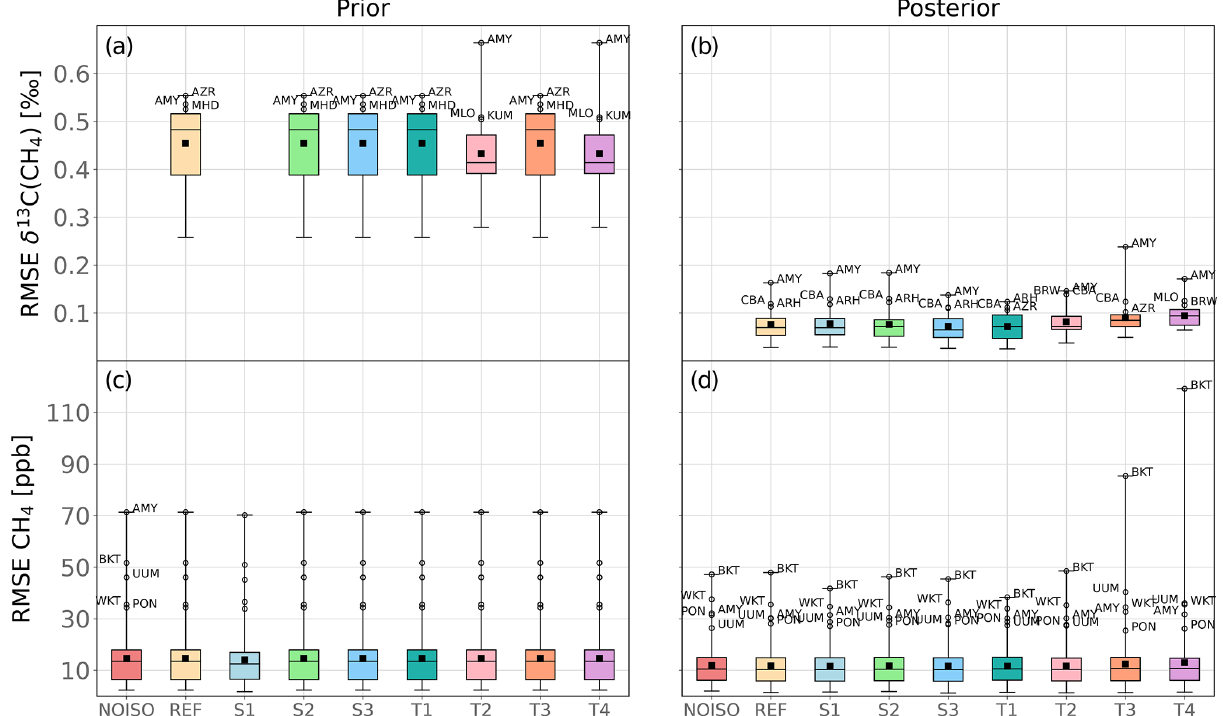
Figure 5. RMSE distribution over the surface stations. Panels (a,c) show the prior CH 4 and δ 13 C ( CH 4 ) RMSE, and panels (b,d) show the posterior RMSE. Panels (a,b) show δ 13 C ( CH 4 ) RMSE, and panels (c,d) show CH 4 RMSE. For clarity reasons, S1 prior is not shown for δ 13 C ( CH 4 ) because the associated prior misfit is much larger than that of the other configurations. The box-and-whisker plots are covering the whole range of data. In panel (c) , all station labels are identical; therefore, most of them are removed to improve the